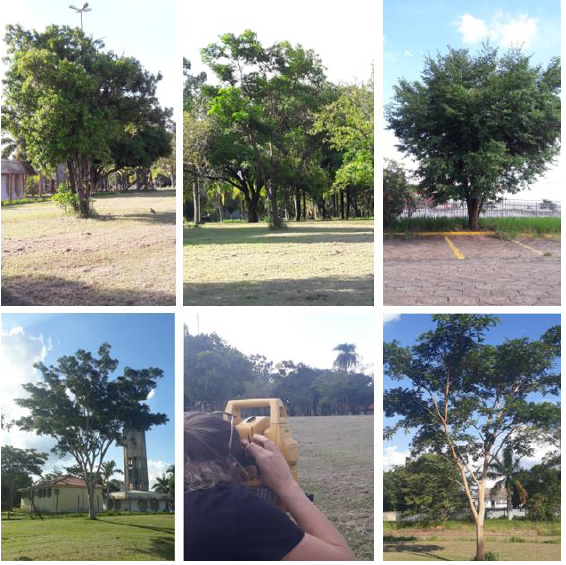
Figure 4. Features of the trees belonging to the test area.